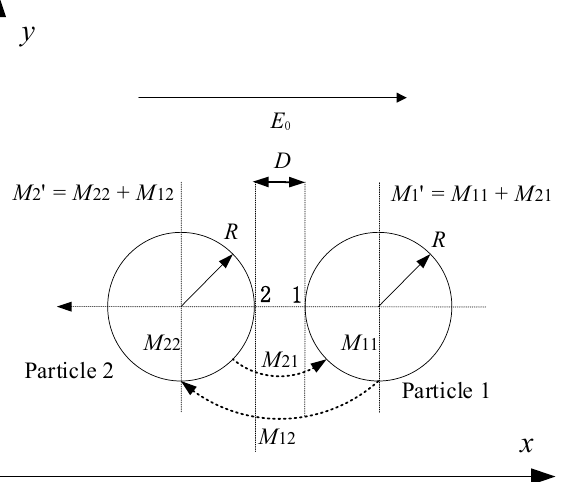
Figure 1. A mutual ‐ coupling dipole model in a two ‐ particle system. Figure 1. A mutual-coupling dipole model in a two-particle